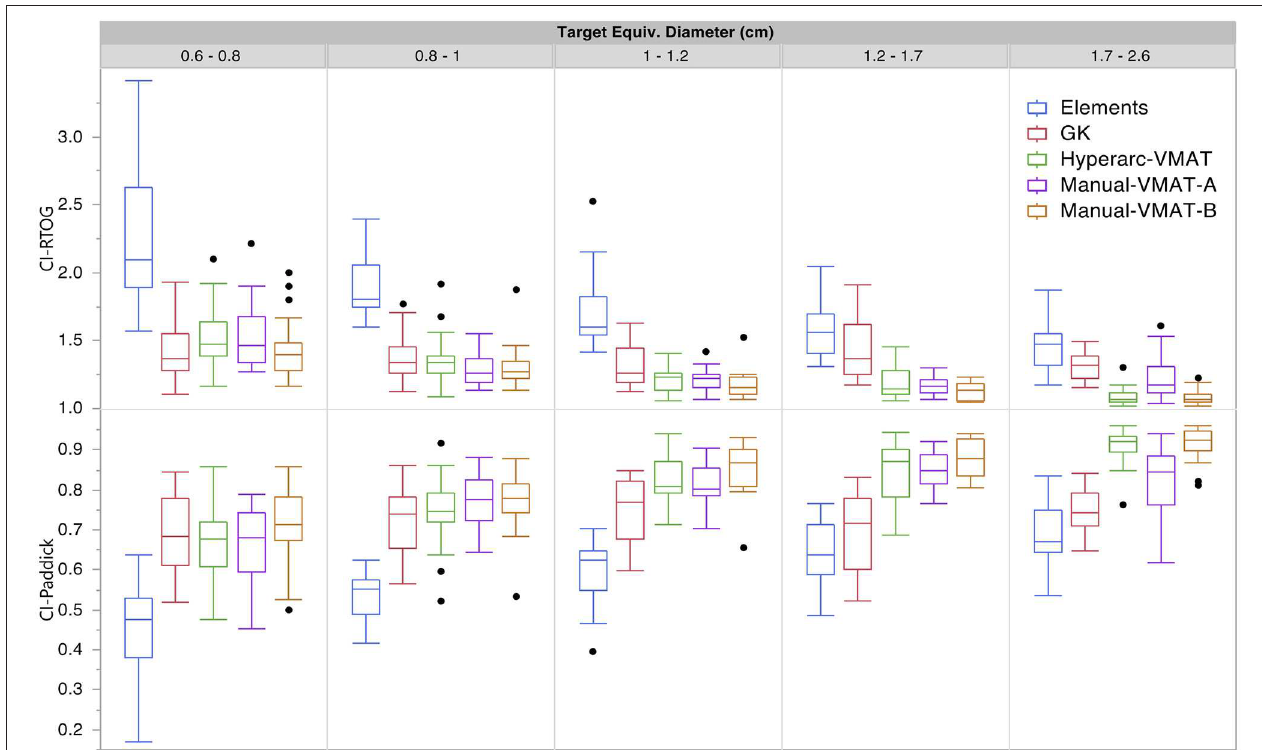
FIGURE 1 | Conformity index results for both RTOG and Paddick definitions displayed as box plots per SRS plan type, divided into five separate target size diameter bins.